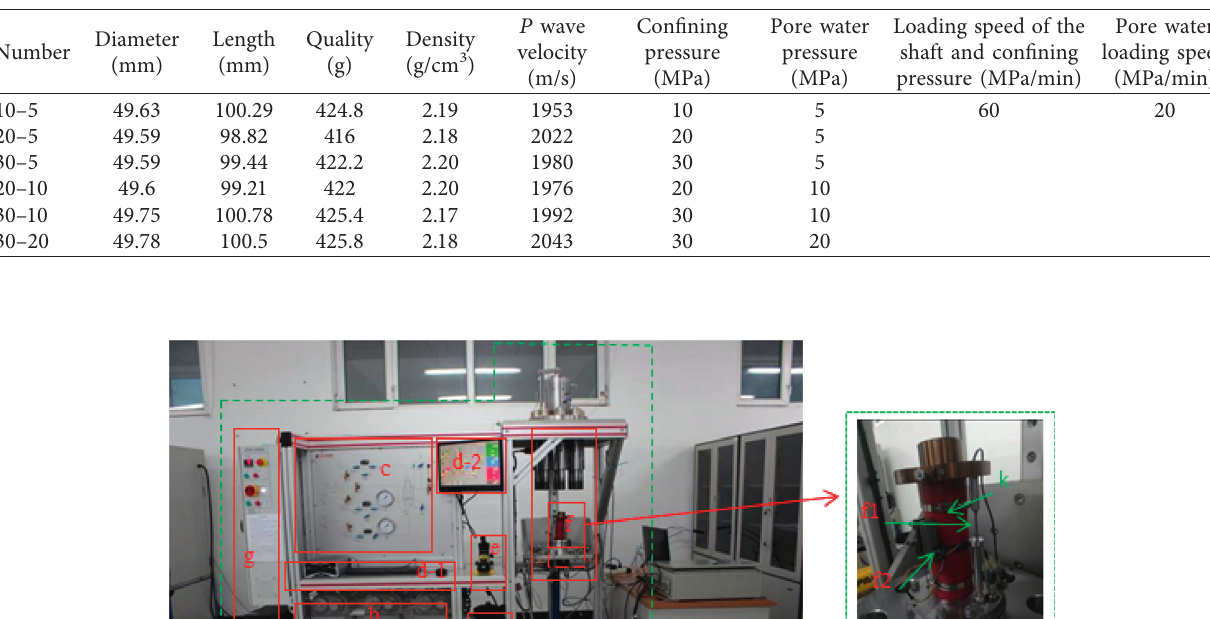
Figure 1: Preparation of sandstone samples. Table 1: Basic information on samples and experiments.